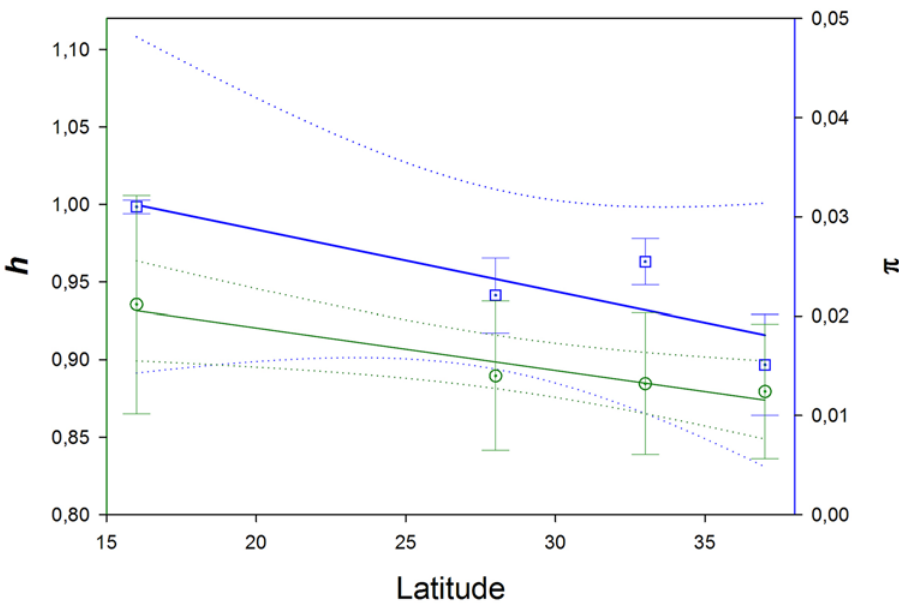
Fig 4. Regression plot of the haplotype diversity and nucleotide diversity. Regression analysis of haplotype diversity ( h ) (blue line) and nucleotide diversity ( π ) (green line) from mitochondrial control region sequences of the Azorean barnacle ( Megabalanus azoricus ), with respect to sampling site latitudes (Azorean, Madeira, Canary, and Cabo Verde